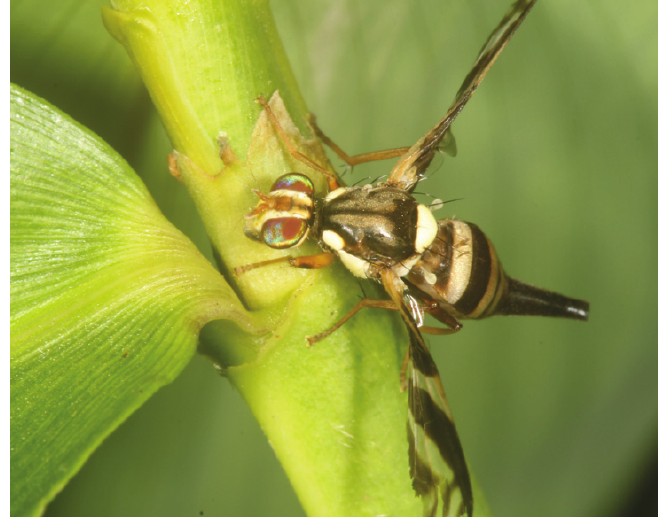
Figure 4. A. rufipes female feeding on secretions of a bamboo extrafloral nectary of Pseudoxytenanthera albociliata